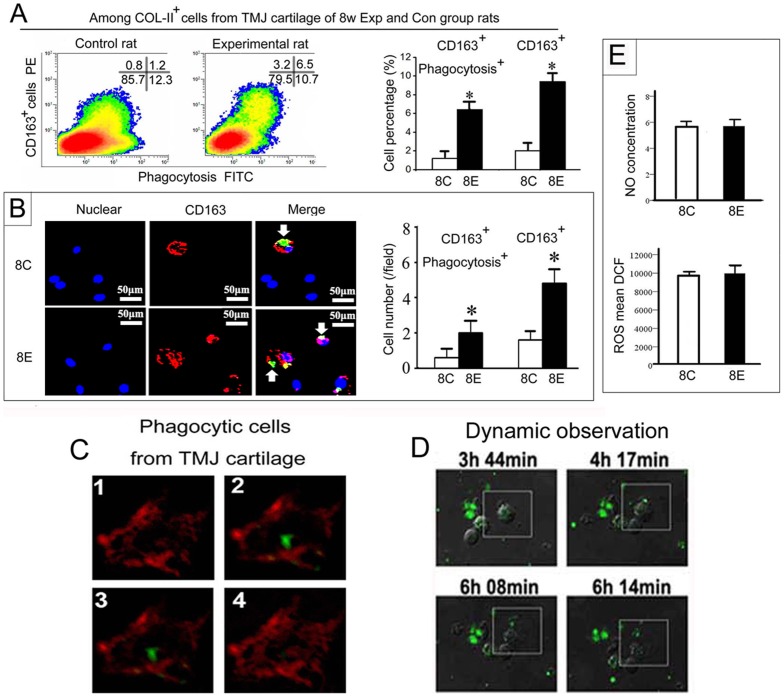
Increase in CD163+ cells with enhanced phagocytic activity in experimentally-induced arthritic cartilage of rat TMJs.A: Flow cytometry analysis and comparison of the percentage of total CD163+ cells and CD163+ cells with phagocytic activity within isolated type II collagen expressing (Col-II+) cells from TMJ cartilage from the 8-week experimental group and their age-matched controls. B: Confocal microscope images of the CD163+ cells and assessment of their phagocytic activity in primary cells isolated from TMJ cartilage. The images reveal an increase in CD163+ cells and enhanced co-localization with the FITC-labeled cell debris in 8-week experimental group compared with the age-matched controls. C: Serial confocal images (1–4) of the primary cells isolated from TMJ cartilage of 3-week old rats co-cultured with DiO-labeled cellular debris. Sections were stained with a CD163 antibody and a Cy3-conjugated secondary antibody. Note that the CD163+ cells showed membrane staining (red) and the cell debris (green) was located inside the cell membrane. D: Dynamic observation of the phagocytic process involving living CD163+ cells sorted from TMJ cartilage engulfing cellular debris. Note that the DiO-labeled debris is undergoing phagocytosis by the CD163+ cell indicated within the white box. E: Comparison of the nitric oxide (NO) concentration and amount of intracellular reactive oxygen species (ROS) in the primary cells isolated from TMJ cartilage from 8-week experimental group and their age-matched controls. *P<0.05.